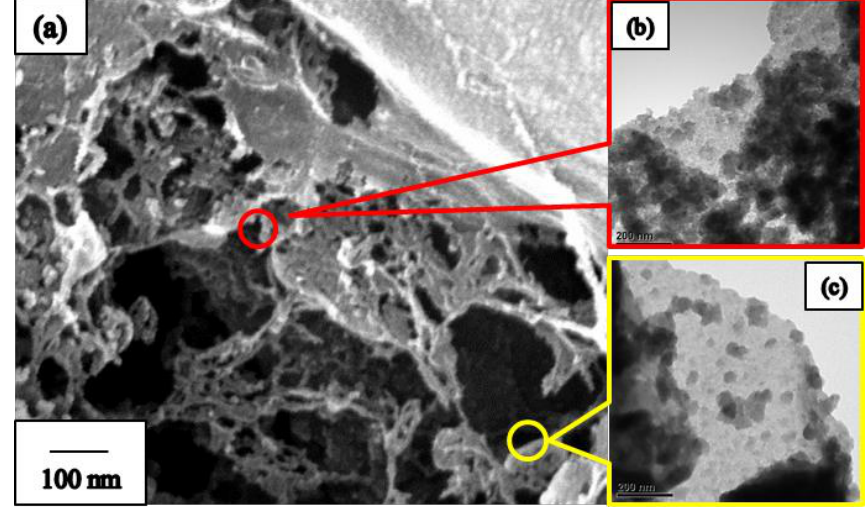
Figure 6. ( a ) FE-SEM image of the 3D BN porous structure, ( b , c ) the transmission electron